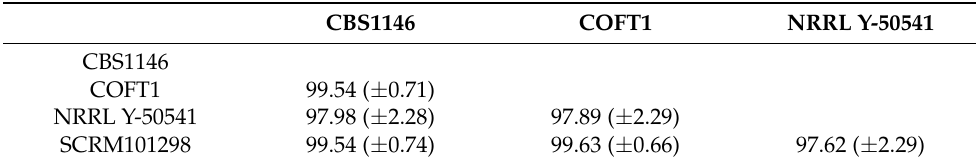
Table 2. Nucleotide identity matrix. The values represent the average amounts of pairwise differences (as a percentage) obtained by comparing the four T. delbrueckii genomes assessed in this work. The standard deviations are indicated between